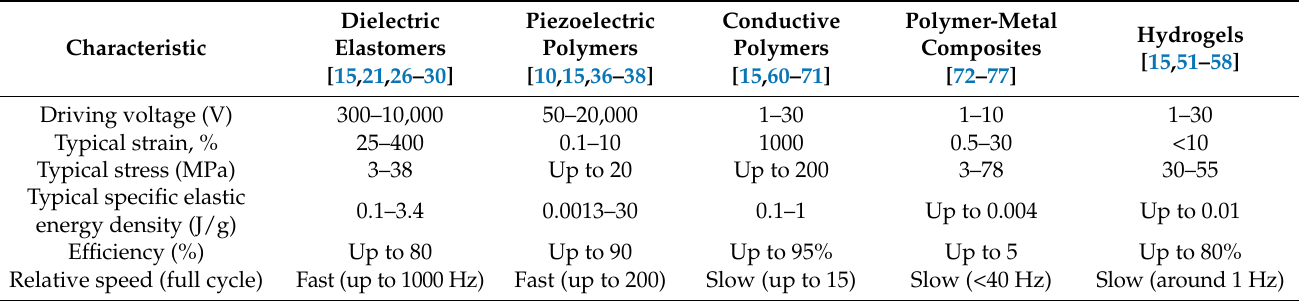
Table 1. Characteristics of electroactive polymers